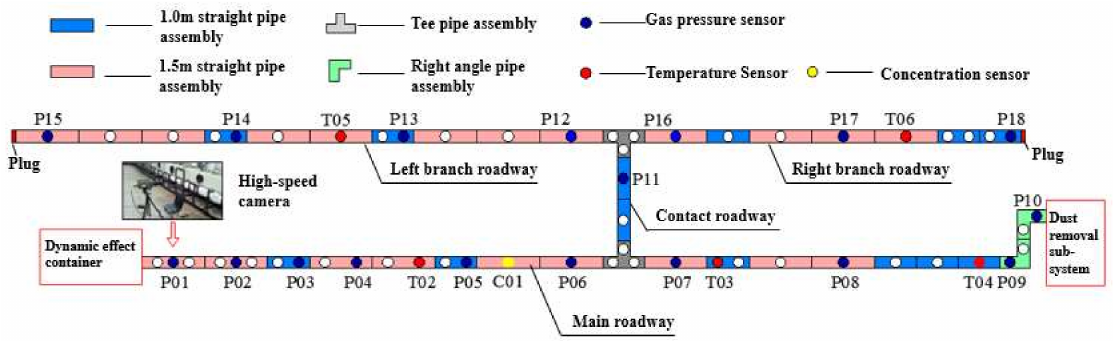
Figure 3. Schematic of test roadway and sensor